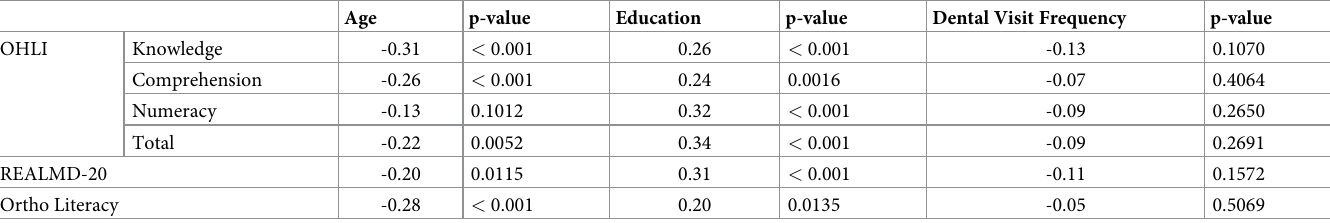
Table 4. Oral health and orthodontic literacy scales correlated with age, education, and dental visit